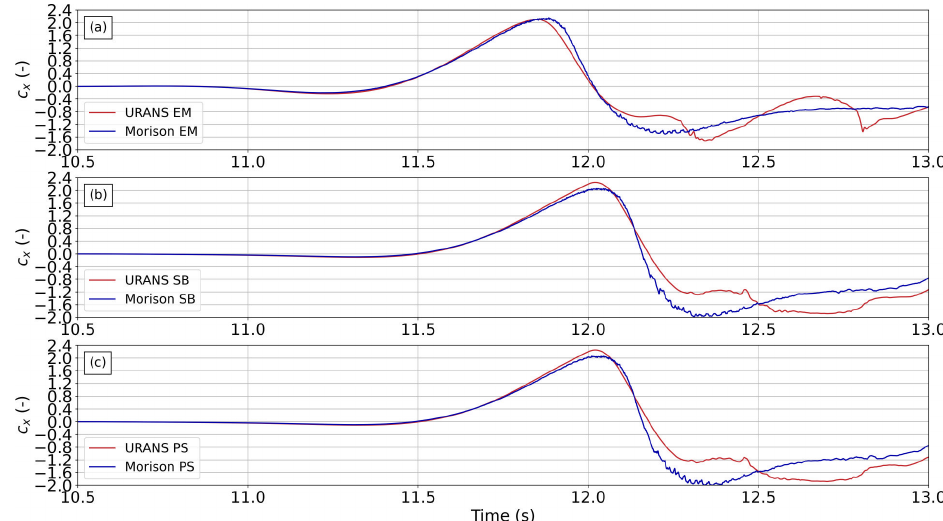
Figure 18. Time histories of load coefficient c x in scenario 2 for the large ‐ diameter upstream cylinder ( a ), for the large ‐ diameter downstream starboard cylinder ( b ), and for the large ‐ diameter down ‐ stream portside cylinder ( c ).